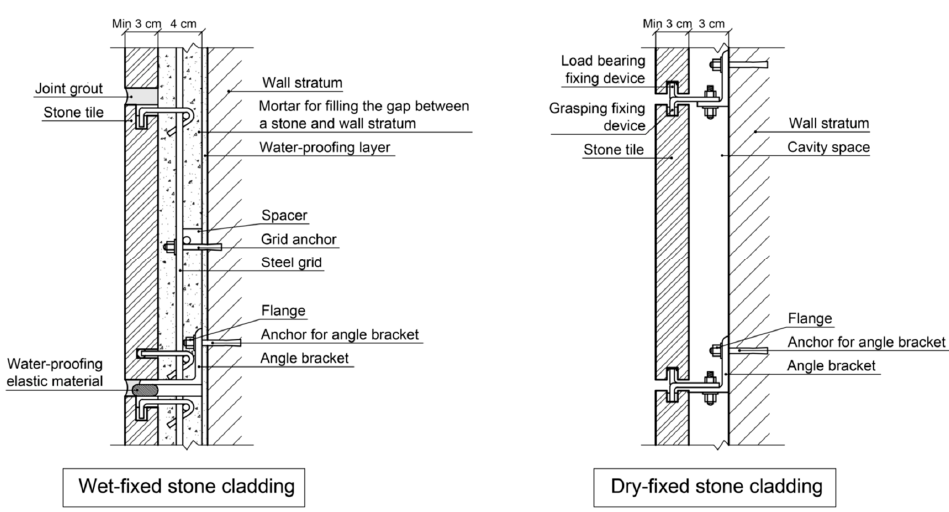
Figure 1. Schematic of a typical wet- and dry- fi xed stone cladding.